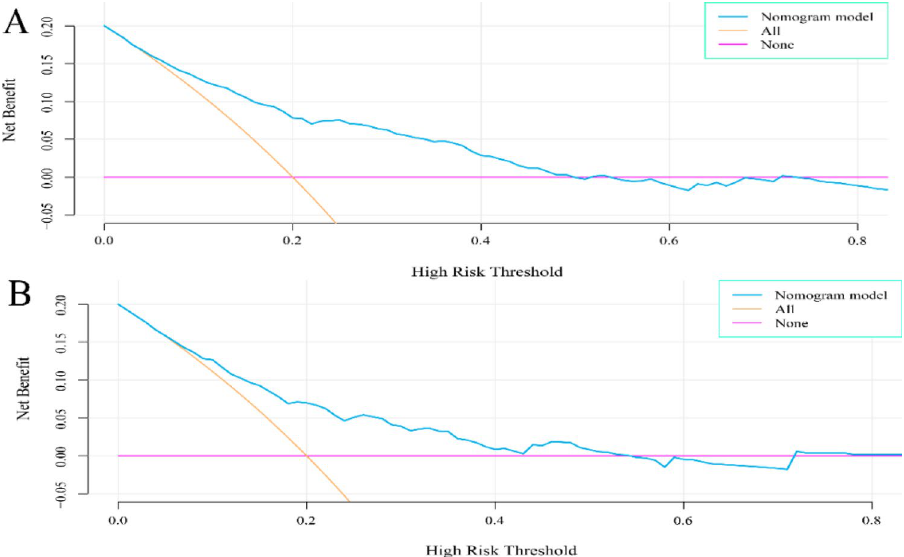
Figure 7. Clinical decision curves for the nomogram model. ( A ) indicates the decision curve for the training set, and ( B ) indicates the decision curve for the validation set. the x-axis shows the threshold probability, and the y-axis shows the net benefit. The purple line represents that all patients did not experience DH, and the orange line indicates that all patients experienced DH. the blue line represents the model; the decision curves show that the model is clinically beneficial within a relatively large range of threshold